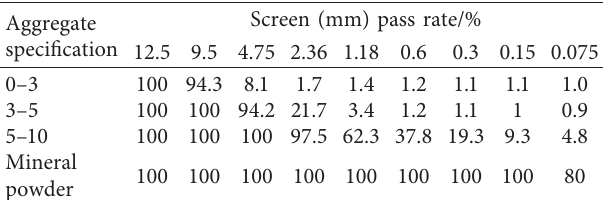
Table 4: Aggregate screening results.